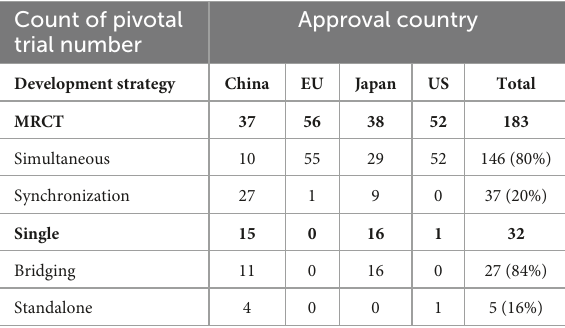
TABLE 6 Summary of development strategy based on MRCTs/single-country